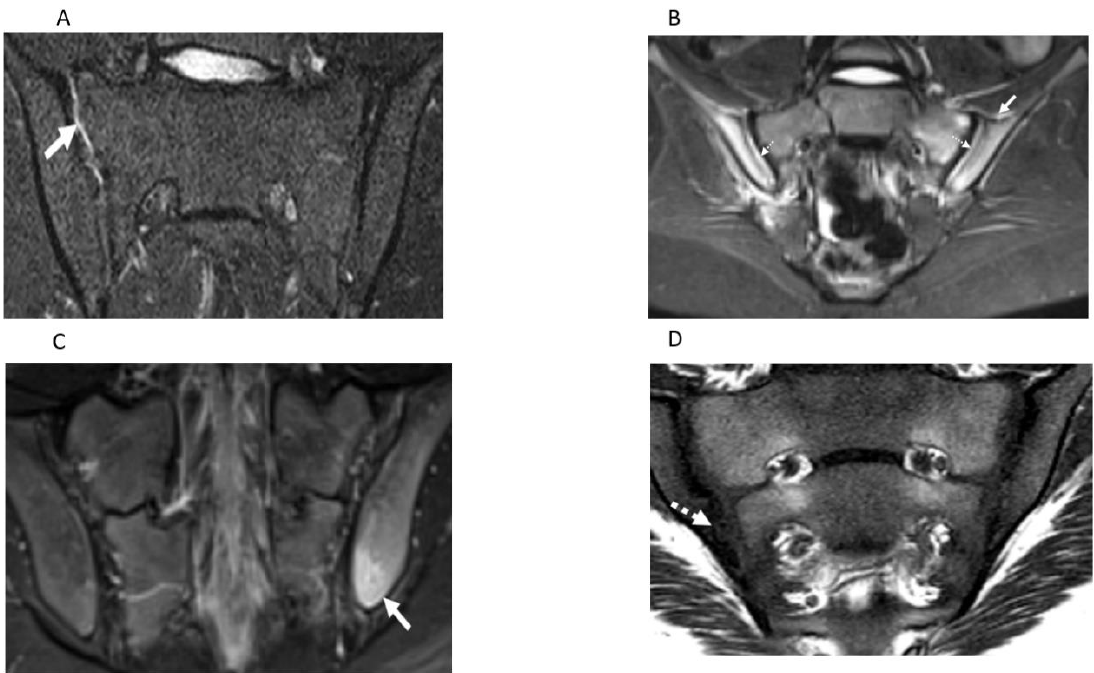
Figure 2. Semicoronal T2 Short Tau Inversion Recovery (STIR) MR images ( A – C ) and T1-weighted MR image ( D ) through the sacroiliac joint (SIJ) illustrate measurement components of the JAMRIS-SIJ. ( A ) SIJ in a 17-year-old boy with ERA/JSpA shows joint space inflammation (JSI) as an increased signal intensity within the superior portion of the right SIJ (arrow) compared to the normal signal in the left SIJ. ( B ) SIJ in a 15-year-old boy with ERA/JSpA demonstrates capsulitis as a high signal intensity (arrow) at the superior aspect of the SIJ and JSI (dashed arrow), which is the most pronounced on the right side. ( C ) SIJ in a 17-year-old boy shows edema in the left iliac bone (arrow) inferior and posterior, consistent with enthesitis. ( D ) SIJ in a 12-year-old boy with enthesitis-related arthritis/juvenile spondylarthritis (ERA/JSPpA) demonstrates erosion involving the inferior aspect of the right ilium (dashed solid arrow). The bony defect at the osteochondral interface in the inferior aspect of the right iliac bone corresponds to the location of bone marrow edema (dashed arrow) seen on theT2-weighted sequence of the image (Figure 1D), consistent with an erosion.